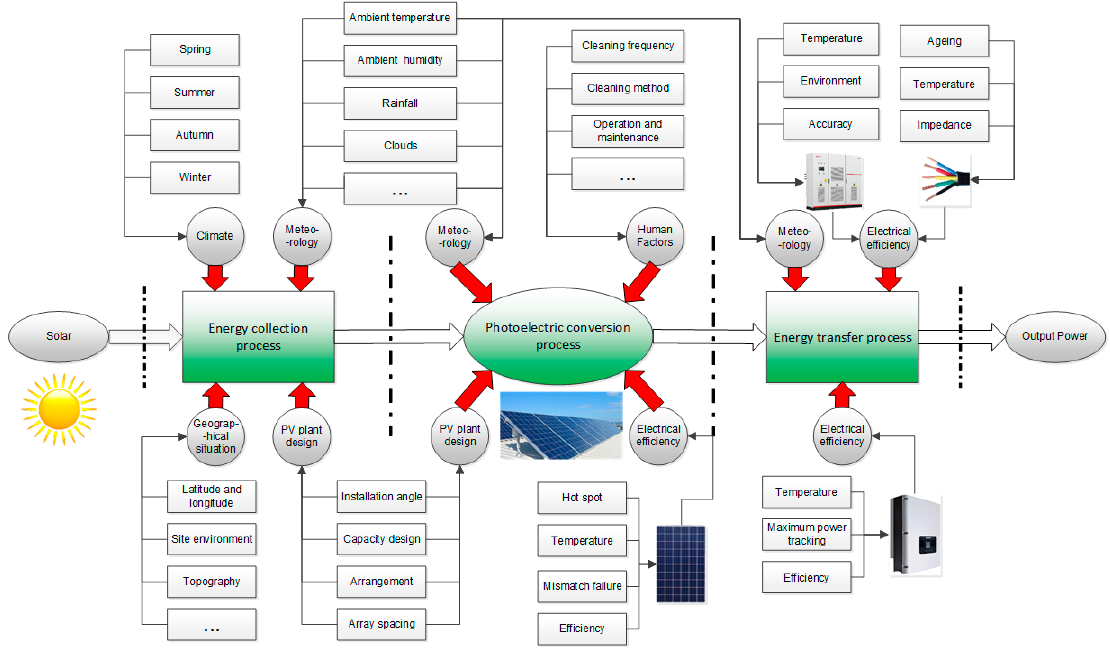
Figure 1. Determinants of photovoltaic (PV) plant output power.